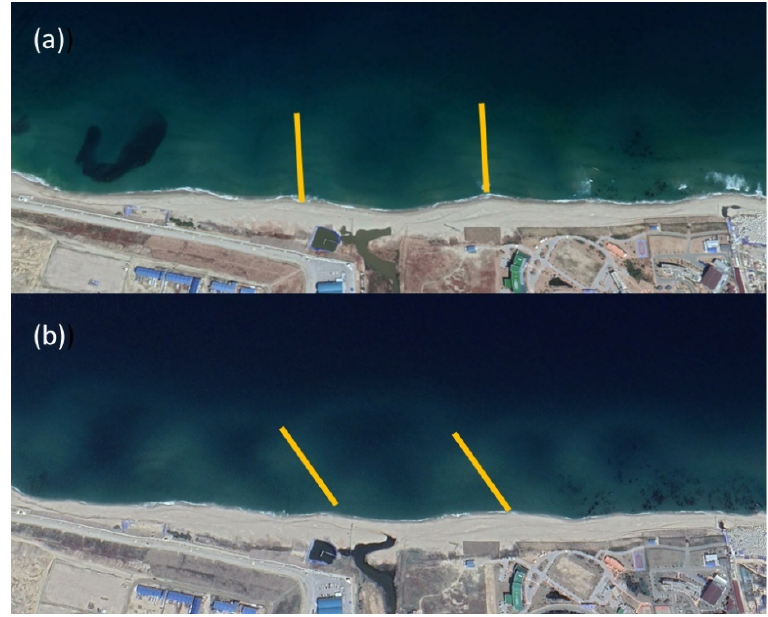
Figure 11. ( a ) Satellite image captured from Google Earth near L1 and L2 measured on 3 March 2018. ( b ) Same location but measured on 20 April 2018. The yellow lines denote the orientation of the horns of the sandbars.